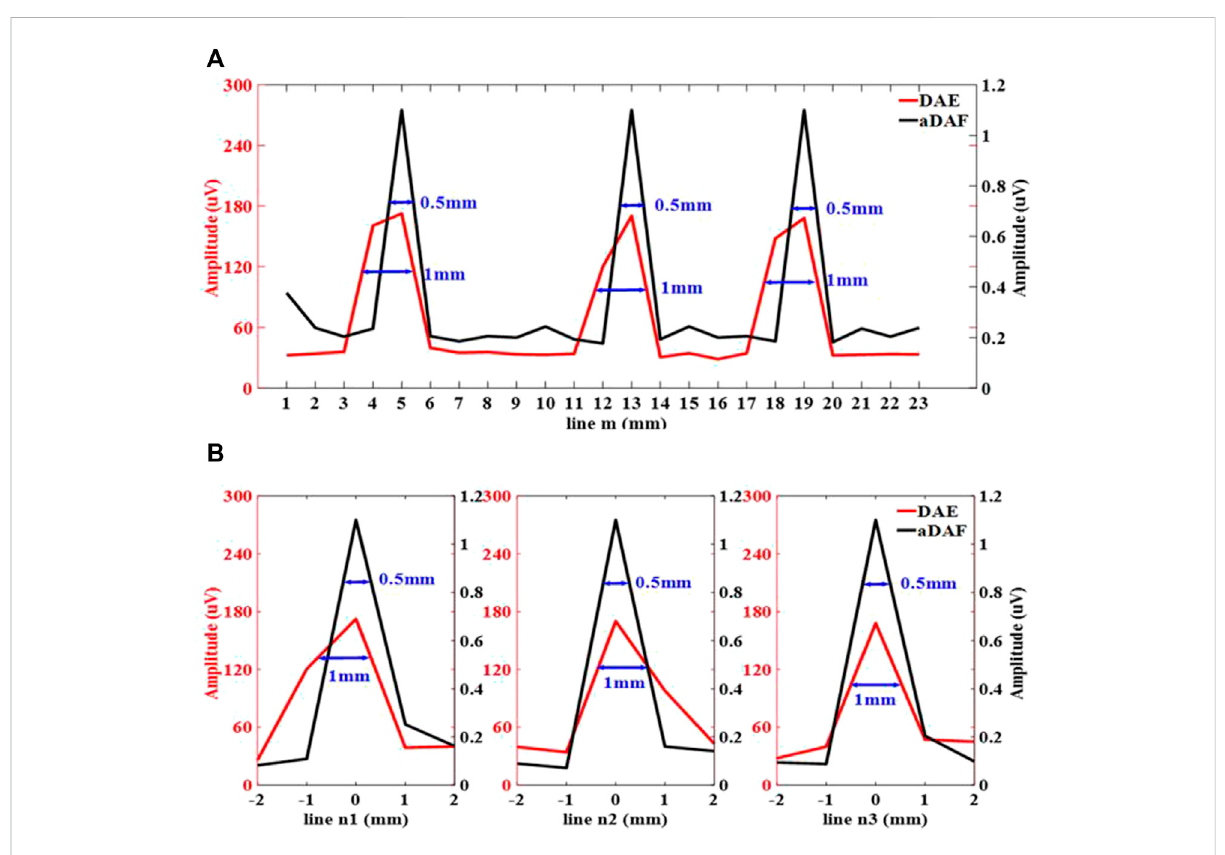
FIGURE 8 Line pro fi les of the decoded signal along the white dashed lines m, n1, n2 and n3 marked in (A) along line m, (B) along line n1, n2 and